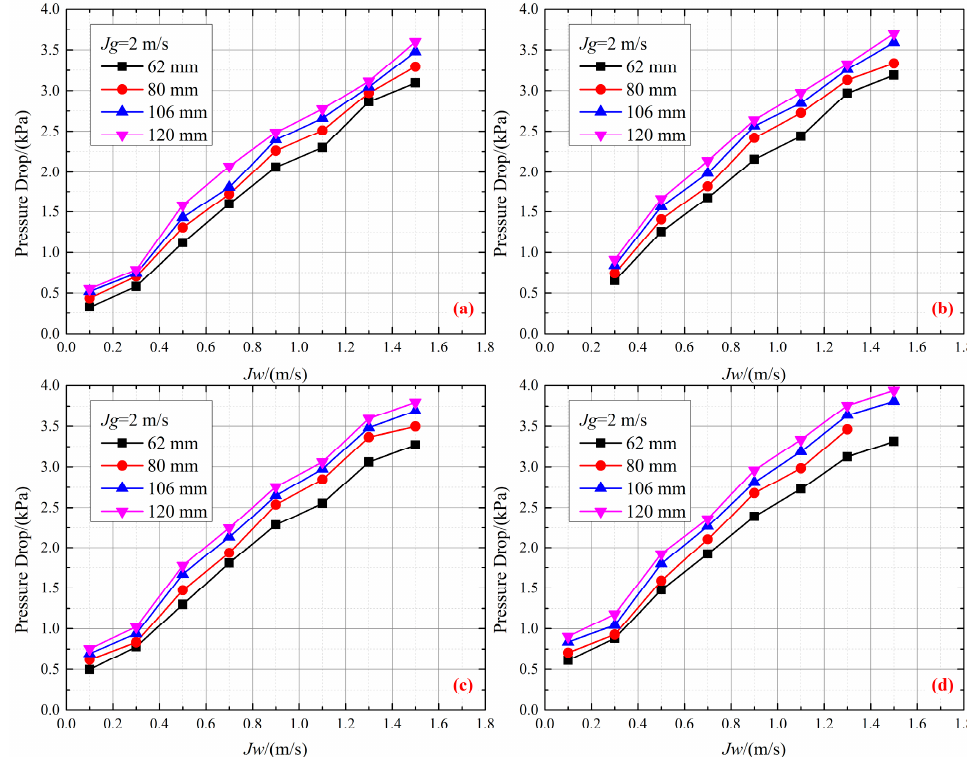
Figure 9. Effect of amplitude on Δ P f : ( a ) H = 0.5 Hz, ( b ) H = 0.8 Hz, ( c ) H = 0.9 Hz, ( d ) H = 1.0 Hz.